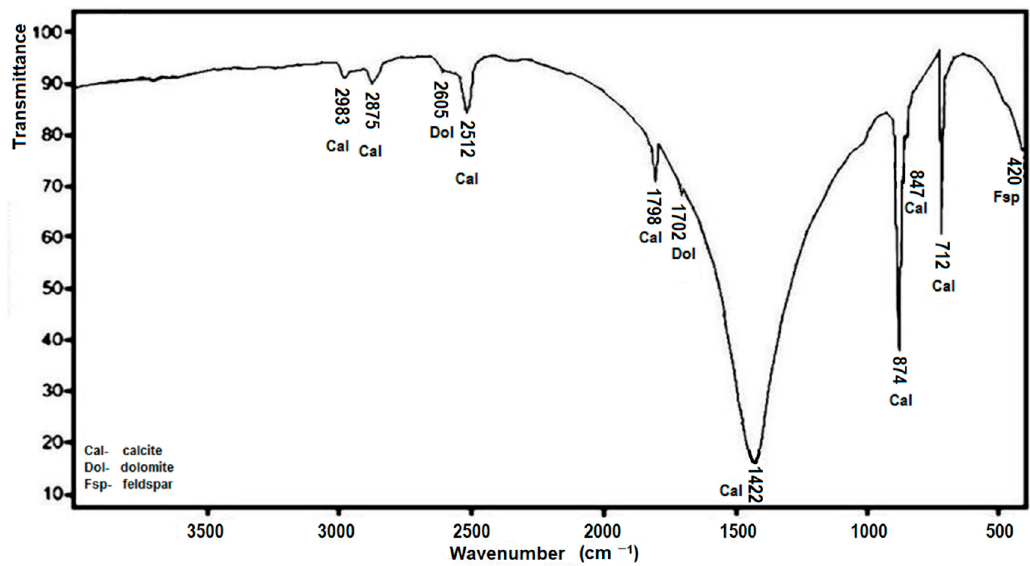
Figure 10. Infra-red absorption spectrum of sample W1, limestone of the Góra ż d ż e Unit taken in the Wysoka Quarry [21,22,24].